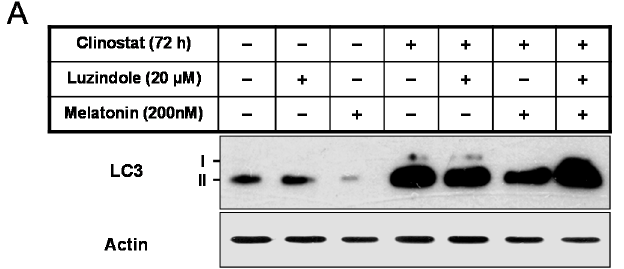
Figure 6. Cont. Figure 6. Cont.